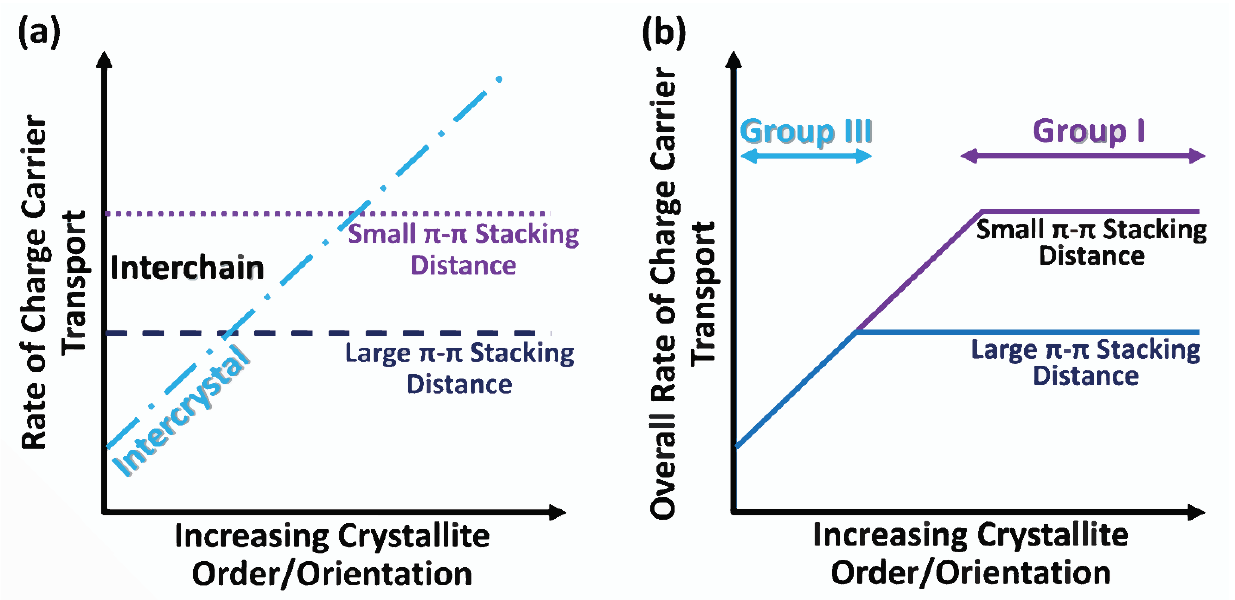
Figure 18. ( a ) The inter ‐ chain transport rate for two different π‐π stacking distances and the inter ‐ crystallite transport rate. The inter ‐ chain transport rate changes as more linear tie chains form with an increase in the order and orientation in conjugated polymers [1]. ( b ) The overall rate of charge transport in conjugated polymers. At a low level of order in the polymer thin film, the inter ‐ crystal transport is the slow step, and the overall rate is enhanced by increasing the order and orientation (Group III). Once a sufficient degree of order and orientation is reached, the rate plateaus, indicating that the inter ‐ chain transport becomes rate ‐ limiting (Group I) [1,11]. ( a , b ) Reproduced with permission [1,11]. Copyright 2020, Elsevier and Copyright 2021, De